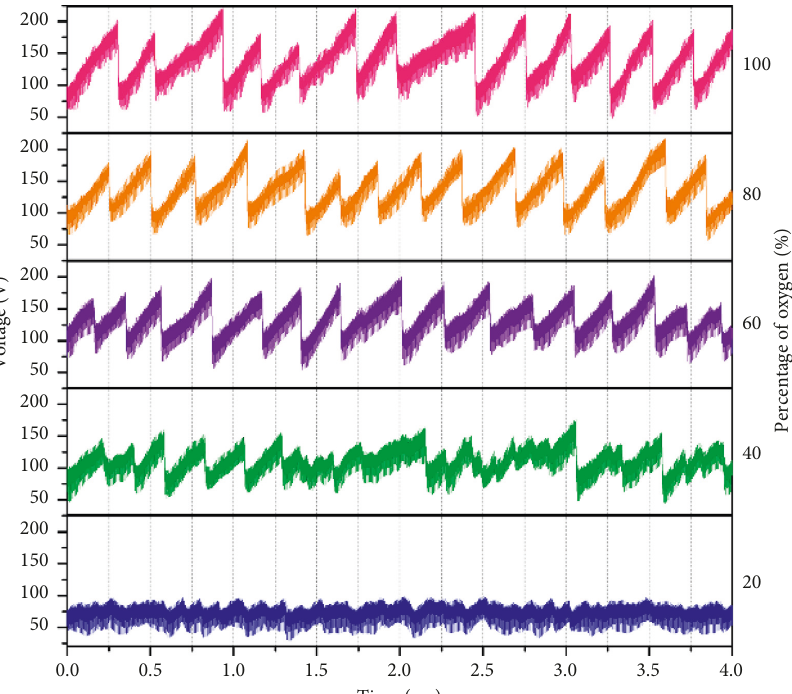
Figure 6: Arc voltage waveform of the plasma igniter under different O